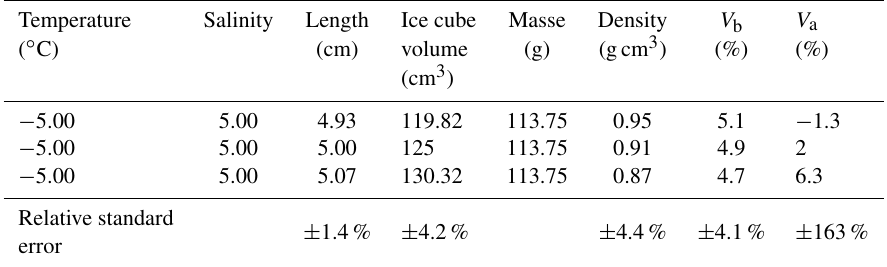
Table 1. Effect of dimensional error on brine volume and air volume fraction computed by mass–volume density measurement using state equation from Cox and Weeks